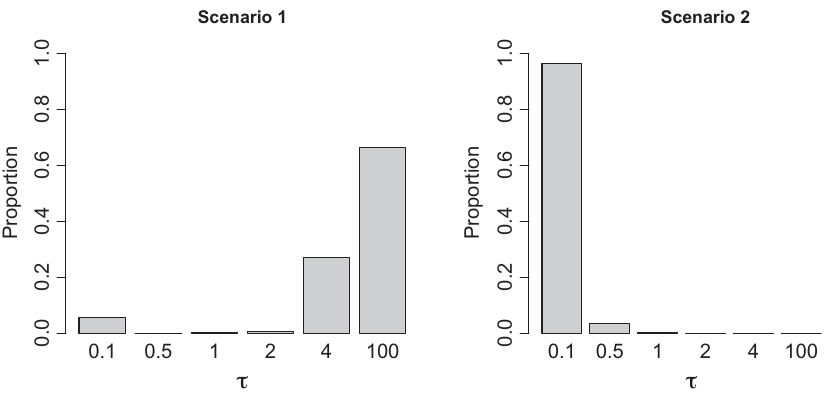
Figure 3: Proportion of times that the algorithm selects certain values of 4 .